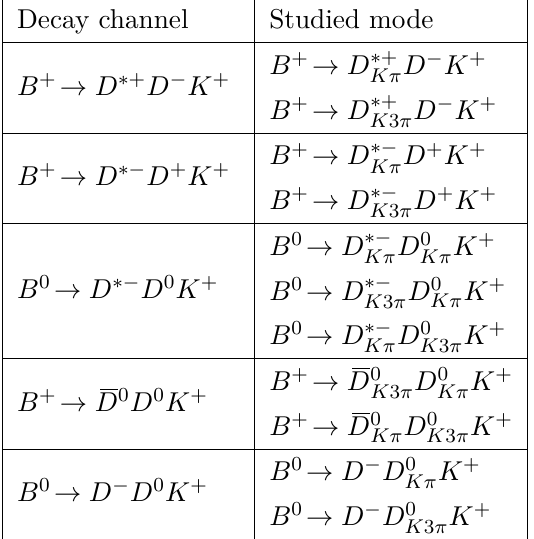
Table 1 . Decays under study. In the first column no assumption about the D final state is made. In the second column, however, the particular D decays are